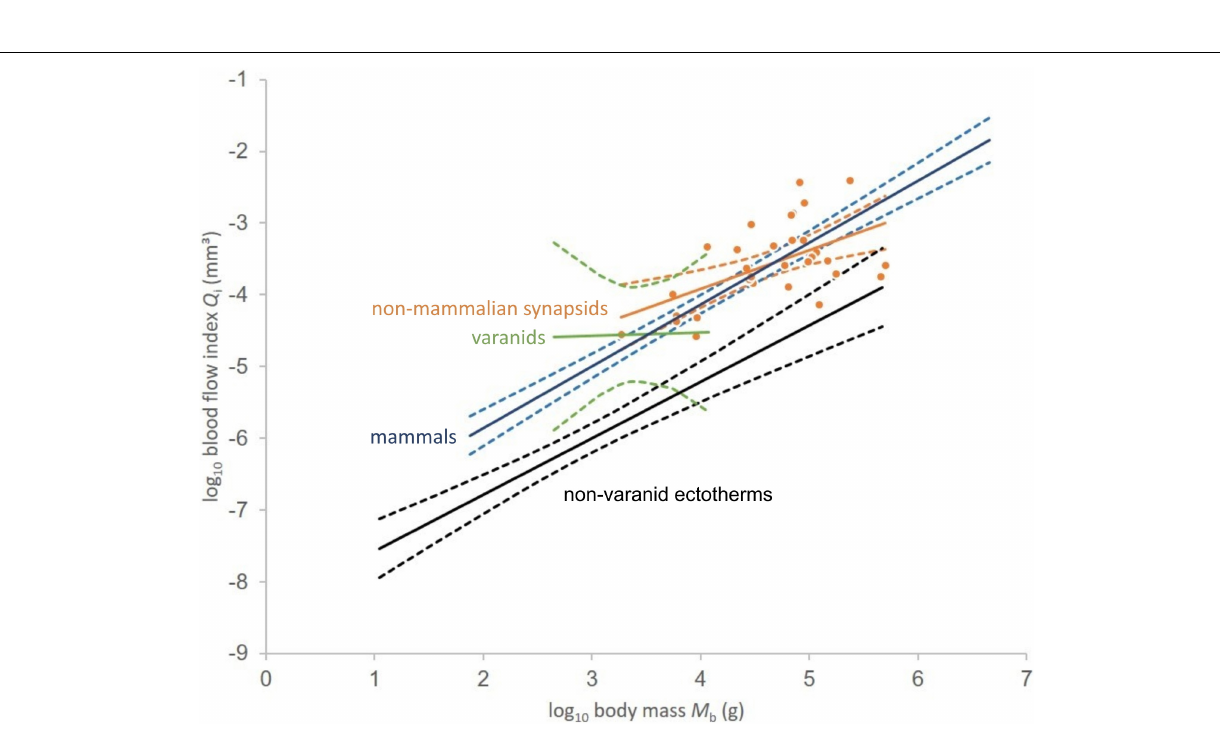
Frontiers in Ecology and Evolution |